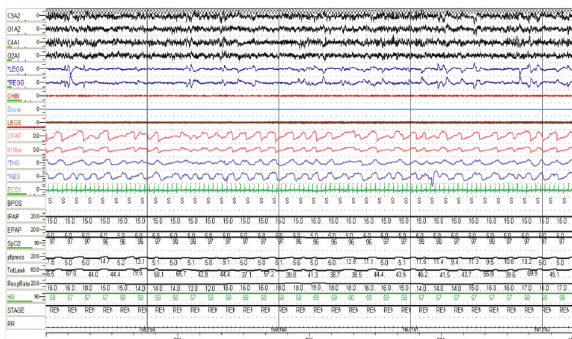
Figure 3: Patient on adaptive servoventilation. Resolution of central events which were noted on CPAP